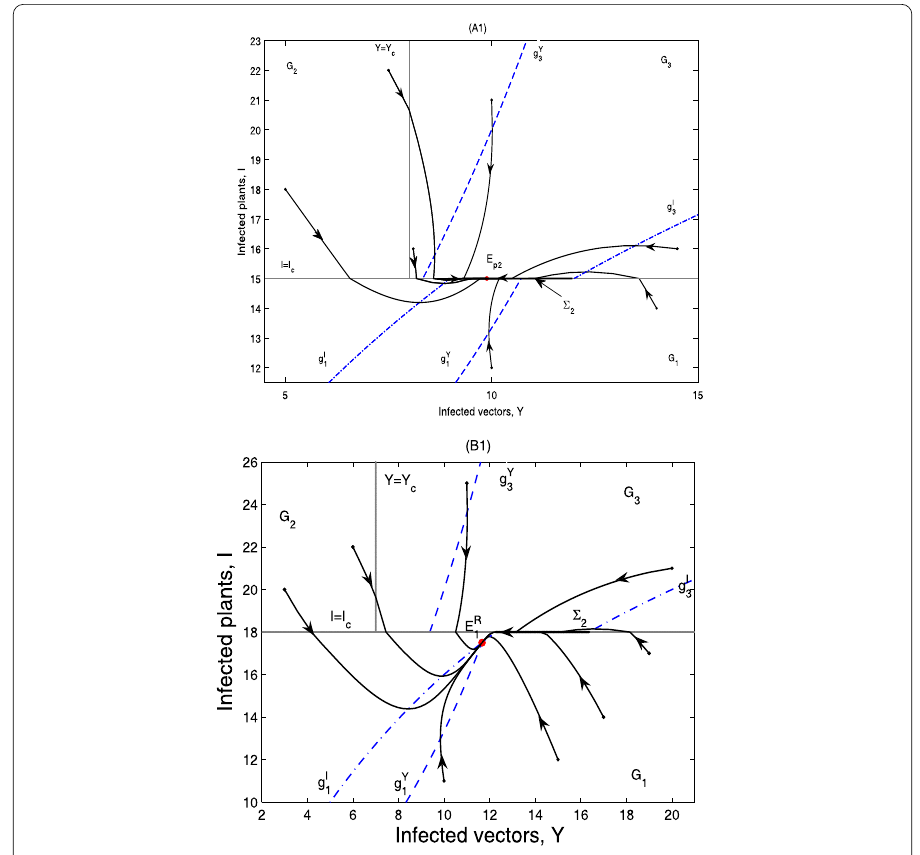
Figure 9 Global dynamics in Case B.13. ( A1 ) E p 2 is globally asymptotically stable. Y c = 8, I c = 15. Σ 3 does not exist. ( A2 ) E p 2 is globally asymptotically stable. Y c = 9, I c = 16. Σ 3 = { ( Y , I ) ∈ Ω 2 : I c < I < g 2 } . ( B1 ) E R 1 is globally asymptotically stable. Y c = 7, I c = 18. Σ 3 does not exist. ( B2 ) E R 1 is globally asymptotically stable. Y c = 10,